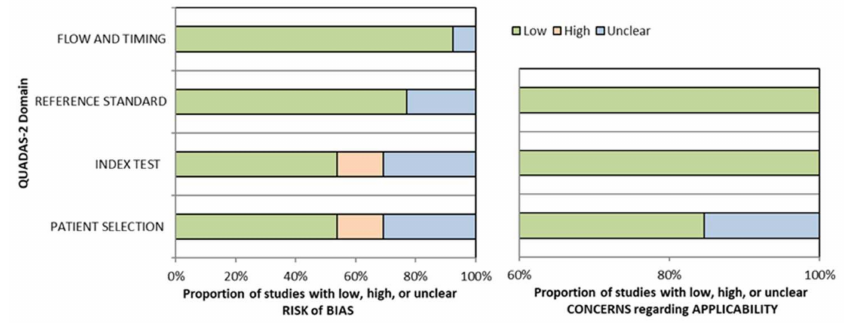
Figure 2. QUADAS-2 assessment of bias and